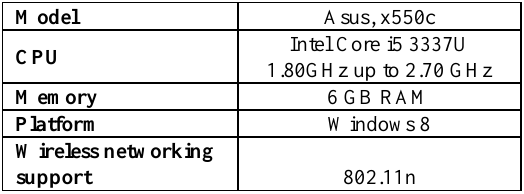
Table 1. The profile of Asus laptop was used for collecting the RSS